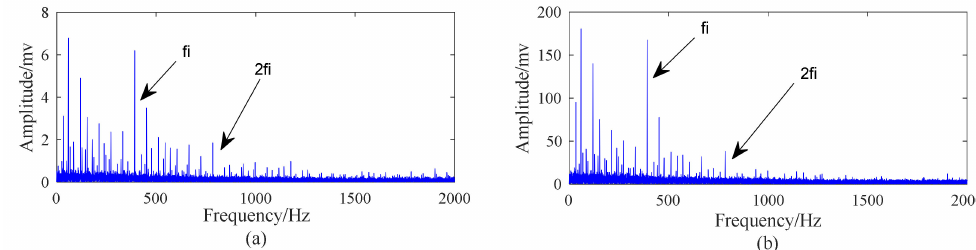
Figure 33. The diagnosis result obtained by IMF4 of the collected signal of the bearing with 1 mm inner race fault: ( a ) the squared envelope spectrum of IMF4; ( b ) the teager energy spectrum of IMF4. The FK and corresponding squared envelope spectrum are presented in Figure 34.